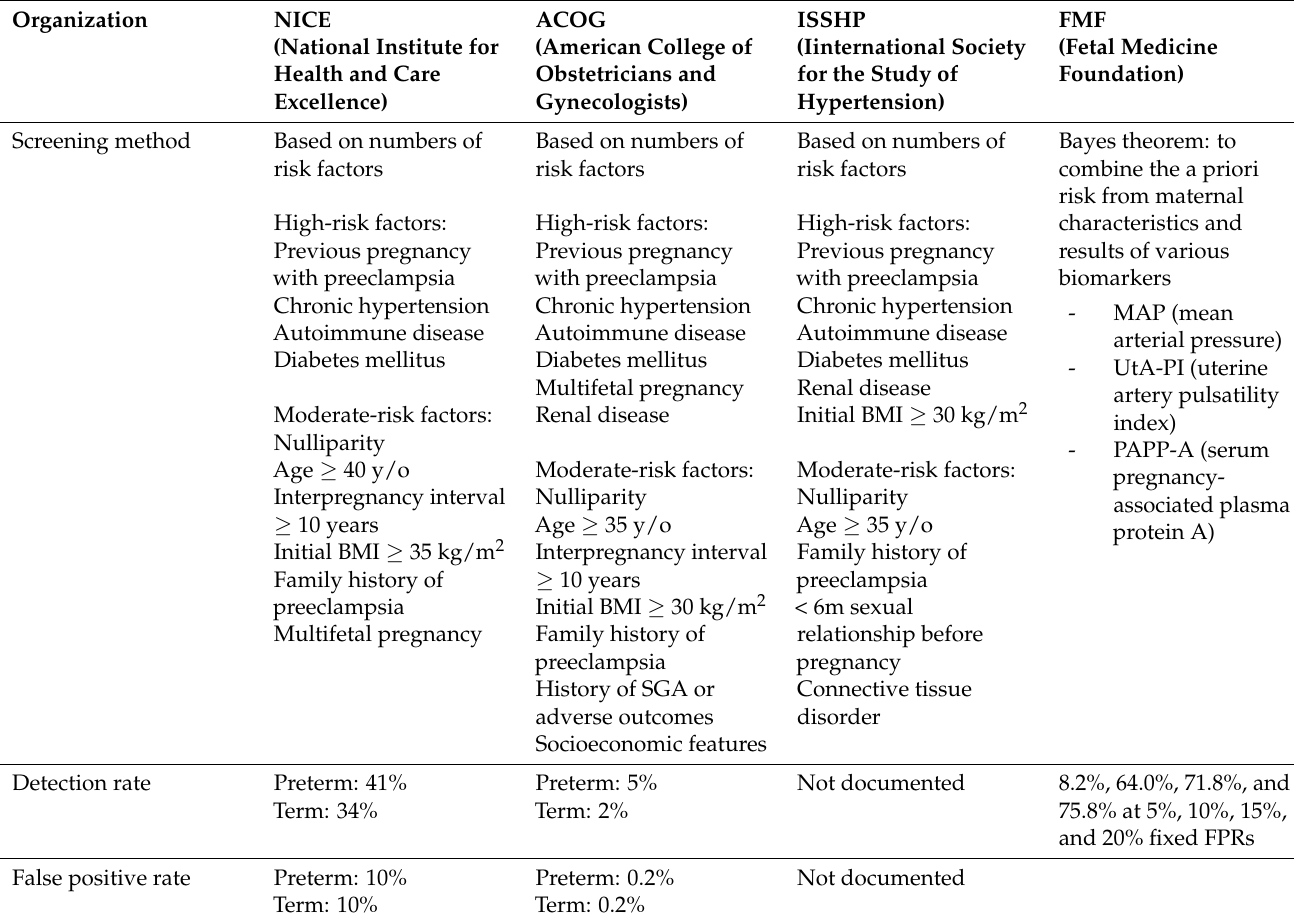
Table 5. A comparison between different prediction models of